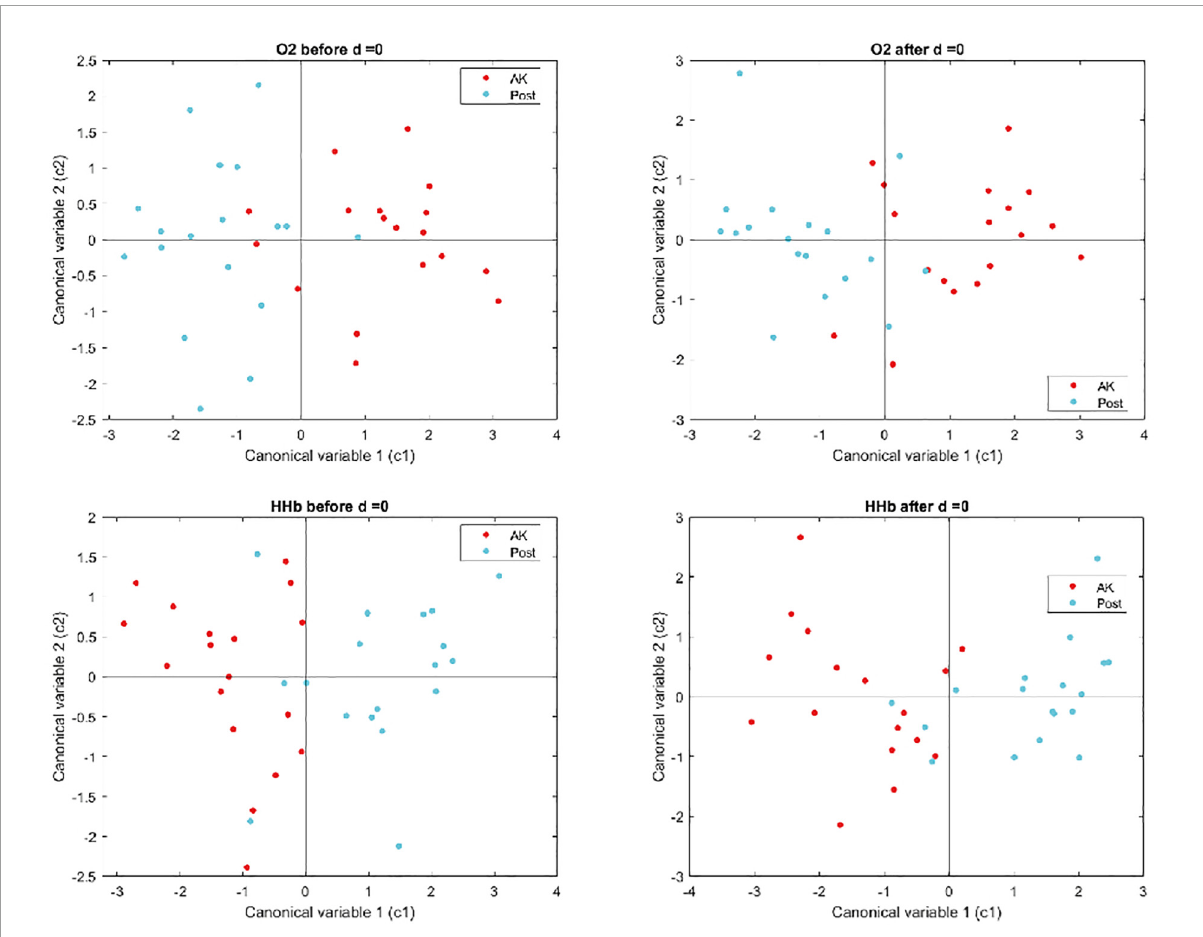
FIGURE5 Graphical representation of the first two canonical variables estimated through the MANOVA for the O 2 Hb and HHb signals, before and after ice